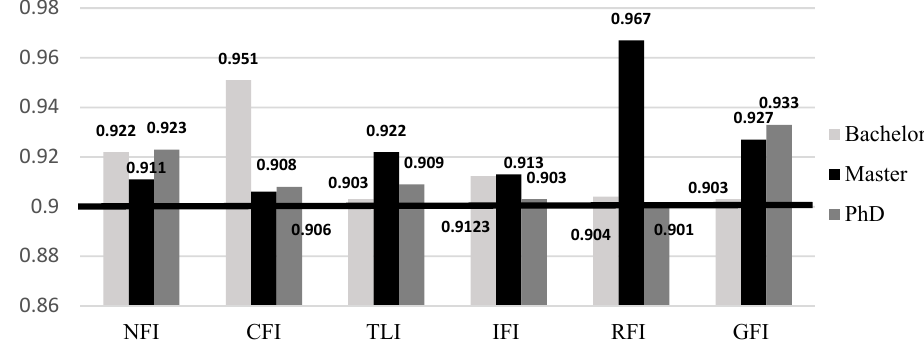
Figure 4. Model fit analysis (NFI: normed fit index, CFI: comparative fit index, TLI: Tucker Lewis index, IFI: incremental fit index, RFI: relative fit index, GFI: goodness of fit index).